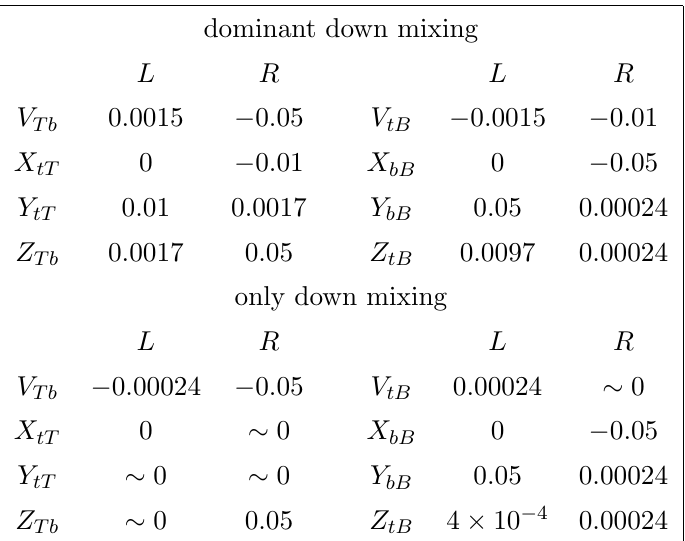
= 0 : 01, s d = 0 : 05 for m T;B = 1 TeV R R (cid:24) 0, s d = 0 : 05 ( s u (cid:24) 0, R R L